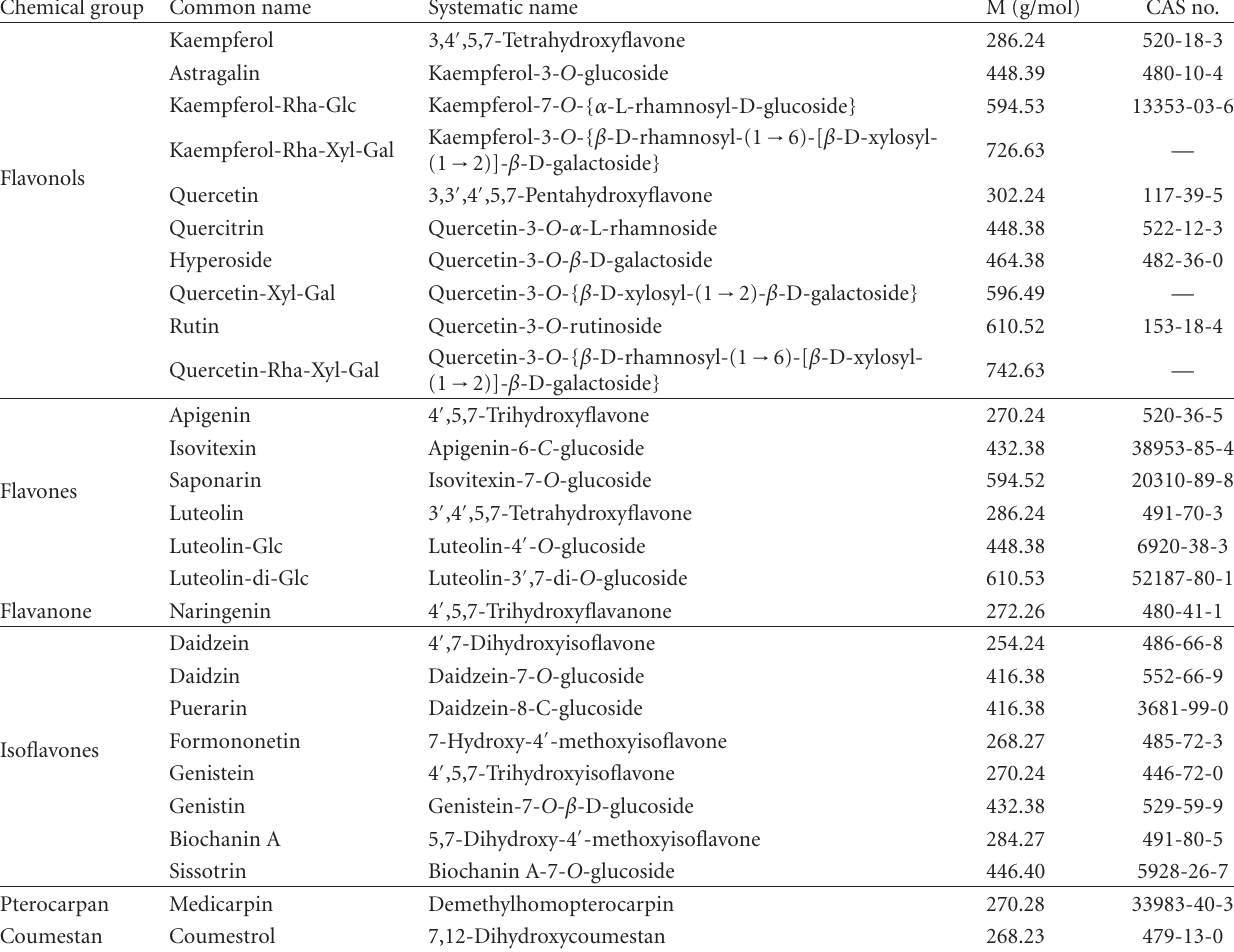
Table 2: Common and systematic names and CAS numbers of compounds quantified in white clover in the present study. Chemical